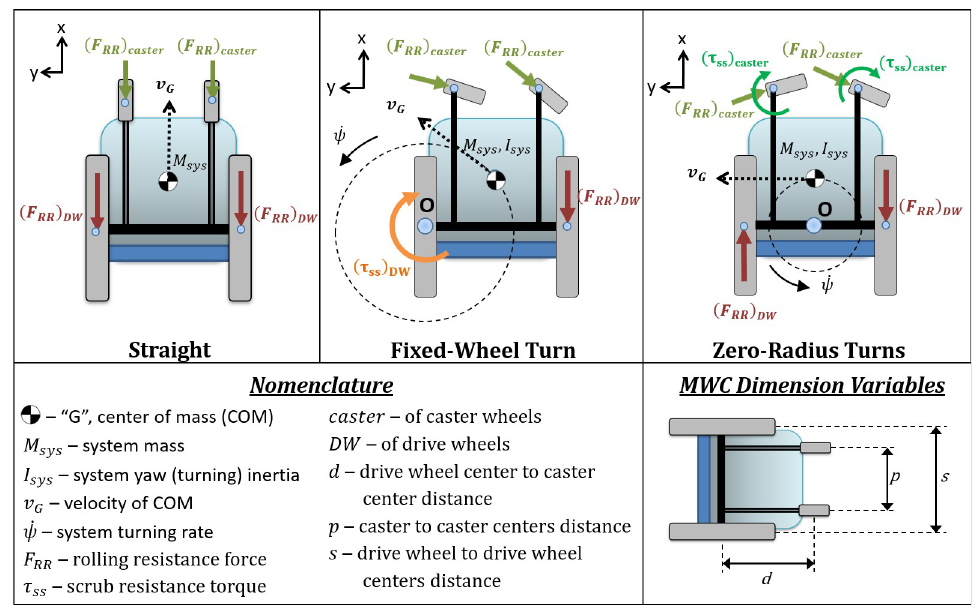
Fig 2. Simplified MWC diagrams. Simplified diagrams displaying the most significant non-conservative forces and torques acting at the interfaces between the ground and the casters and drive wheels.